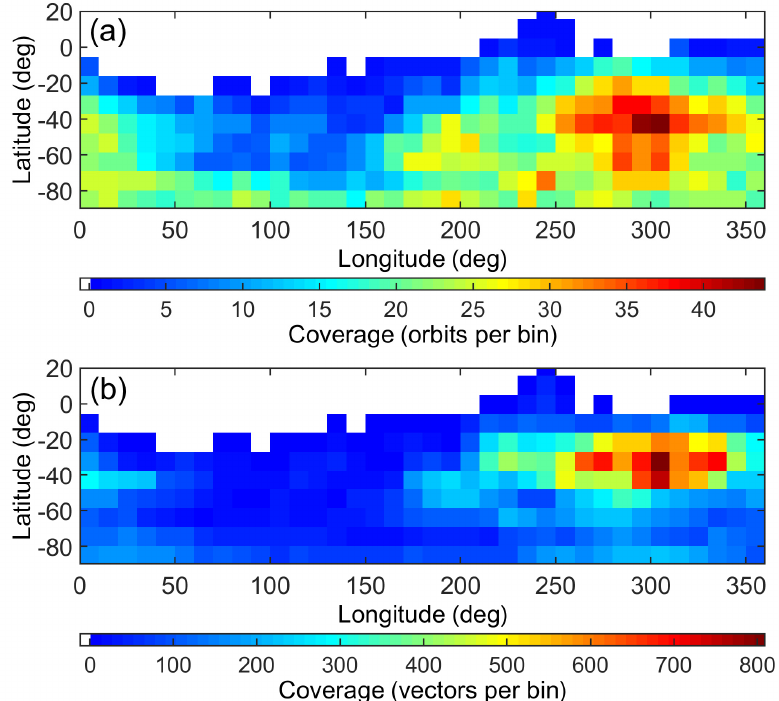
Figure 2. Coverage of Venus nightside in longitude—latitude coordinates by velocity vectors re- trieved in this work. This distribution uses 10 ◦ longitude × 10 ◦ latitude bins. ( a ): number of orbits (per bin) that were eligible for velocity retrieval. ( b ): number of vectors (per bin) retrieved in total.